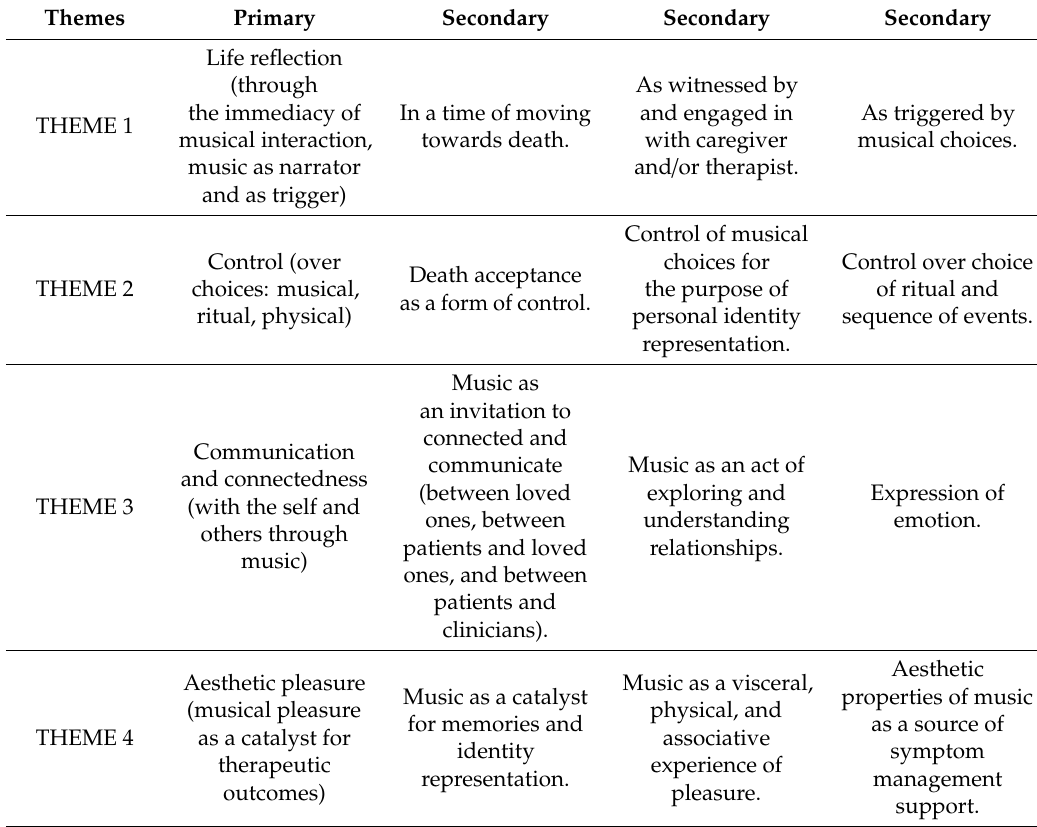
Table 2. Primary and secondary themes for